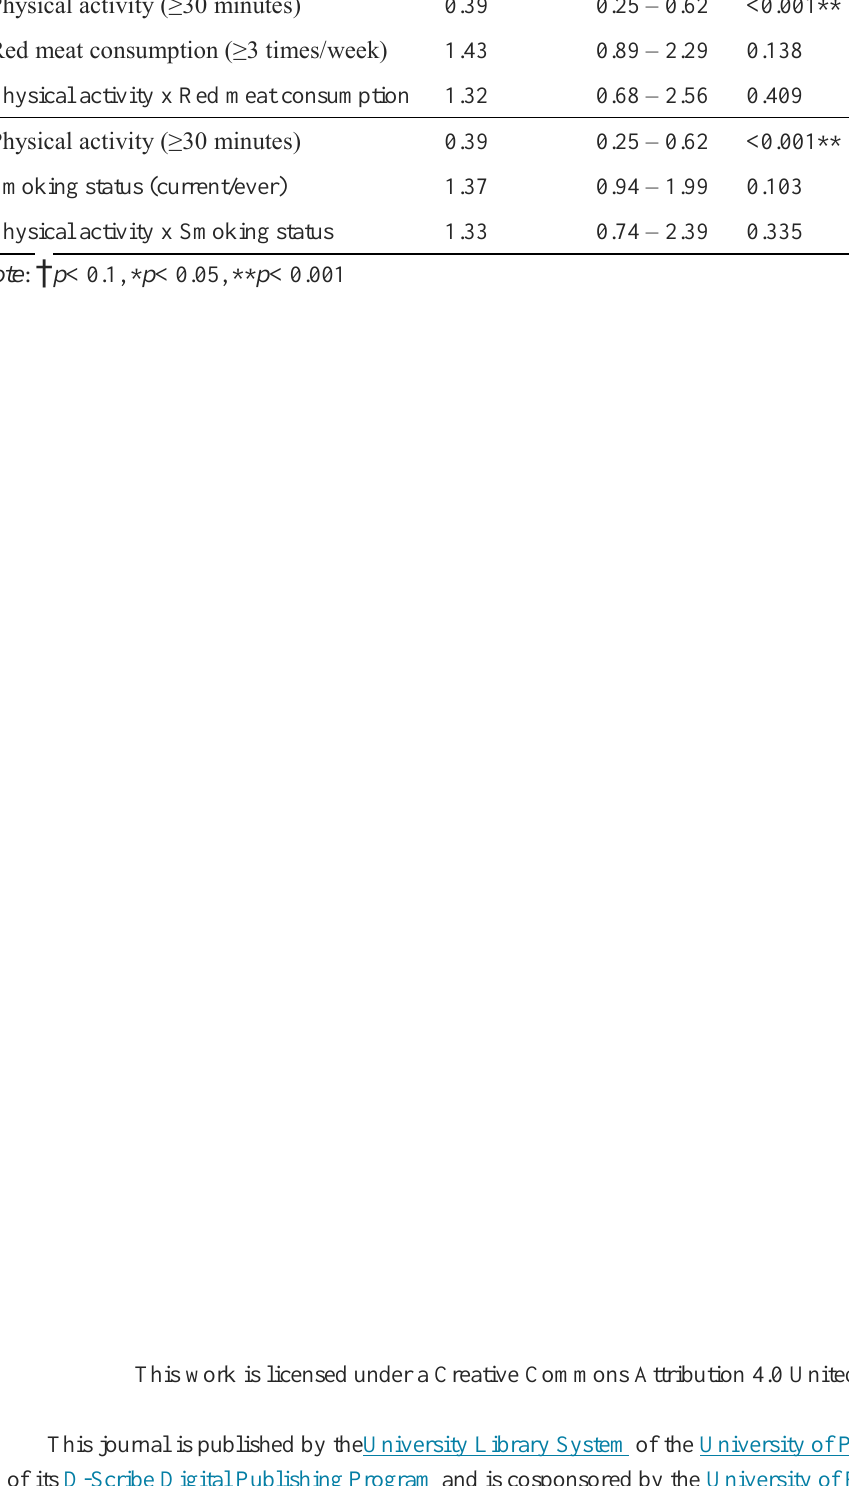
Table 3.Logistic regression of predictors of cardiovascular diseases: Examining interactions Odds Ratio 95% CI p -value Physical activity (≥30 minutes)